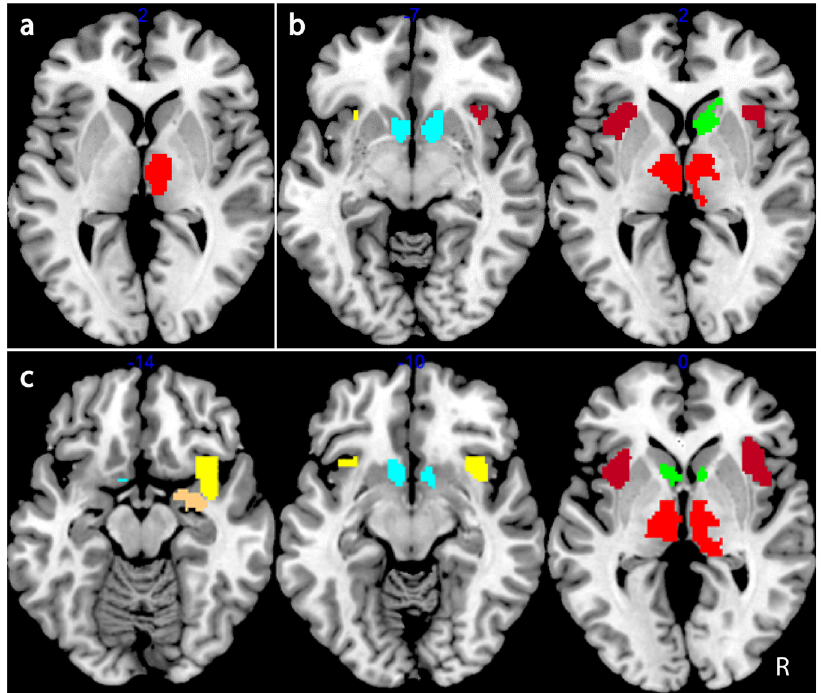
Fig. 2 Validation analysis. Clusters of higher activation for reward + punishment versus neutral conditions for the valence ( a ) and magnitude ( b ) cue period as well as high versus low + neutral for the magnitude cue period ( c ). Clusters thresholded at p < 0.005 for visualisation purposes. Red = thalamus; green = caudate; cyan = nucleus accumbens; peach = amygdala; brown = dorsal anterior insula; yellow = ventral anterior